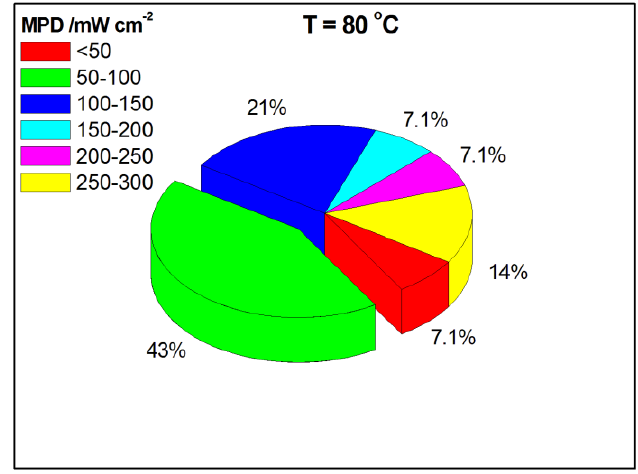
Catalysts 2019 , 9 , x FOR PEER REVIEW Figure 7. Pie chart of the MPD of ADGFCs operating at 80 ◦ C. Figure 7. Pie chart of the MPD of ADGFCs operating at 80 °C.